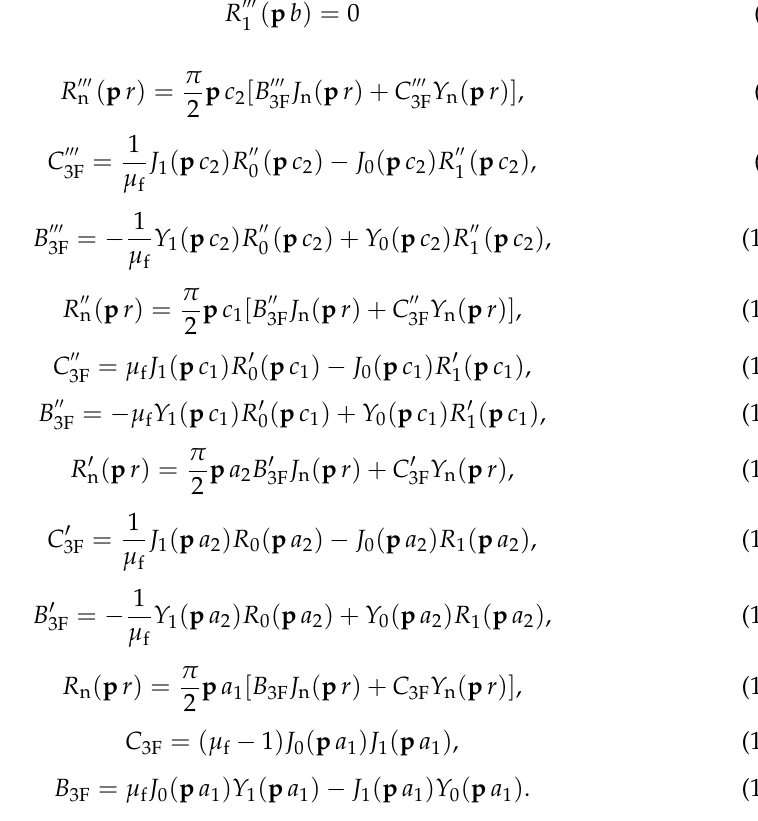
Figure 2. Rectangular cross-section of the pot-core sensor placed above a three-layer conductive structure.